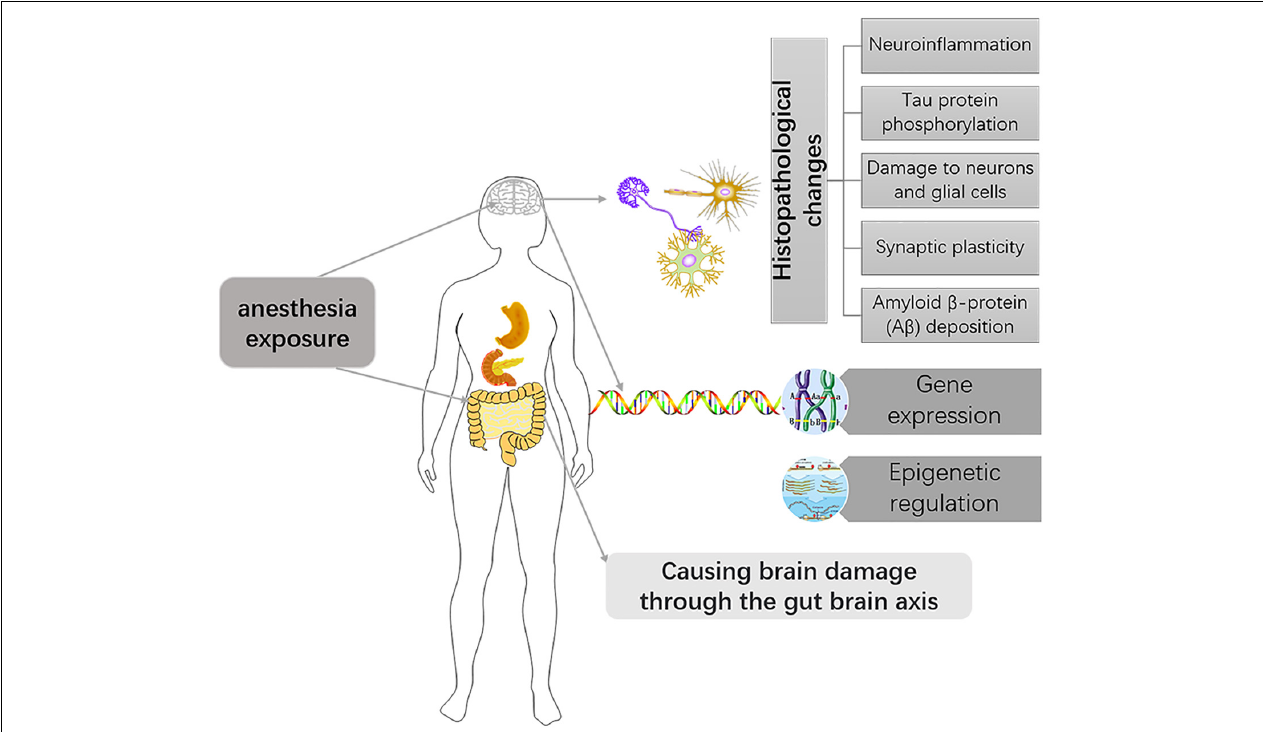
FIGURE 3 | Mechanisms of anesthesia exposure induced developmental brain